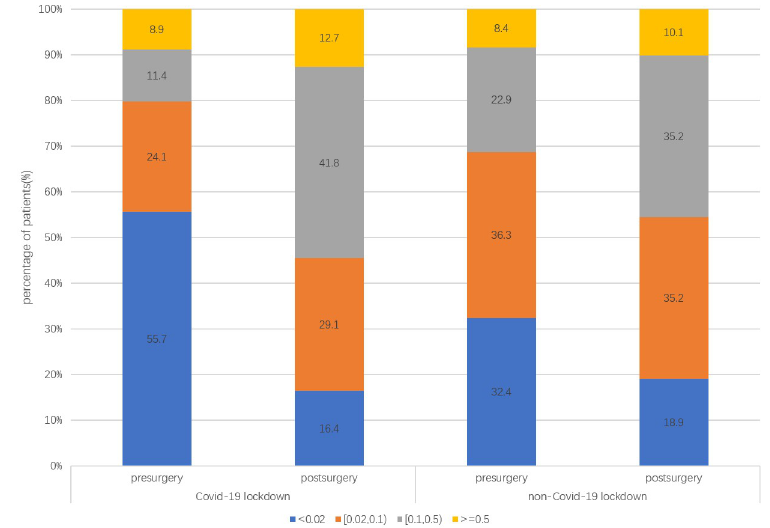
Fig 1. VA distribution of the patients. There were more patients with poor VA in the presurgical VA (less than 0.02) in the COVID-19 pandemic group than in the pre-COVID-19 group (55.7%, 32.4%, p = 0.009). There was no significant difference in the distribution of postsurgery VA in the two groups (p = 0.73).